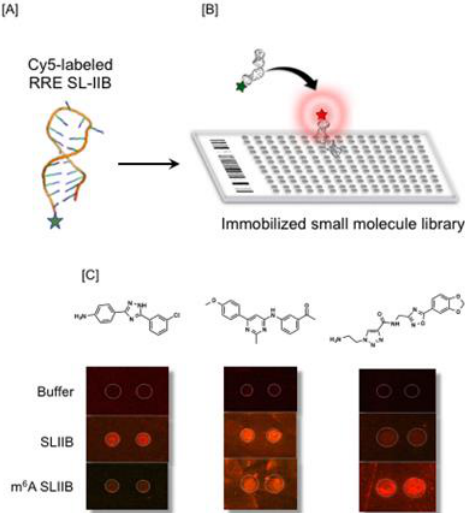
Figure 8. Screening for small molecules that recognize m 6 A-modifed HIV-1 RRE SL-IIB. ( A ) A synthetic RNA fragment harboring the m 6 A modifications reported in SL-IIB is labeled with Cy5 on its 3′ terminus. ( B ) Labeled SL-II RNA was flowed over microtiter plates containing covalently immobilized small molecules. Binding of RRE SL-II RNA to candidate ligands was recorded via a fluorescence signal. ( C ) HTS screening suggests specificity of small molecules for unmethylated (left) and methylated SL-IIB (right). The central panel highlights a ligand that recognizes both SL-II forms.